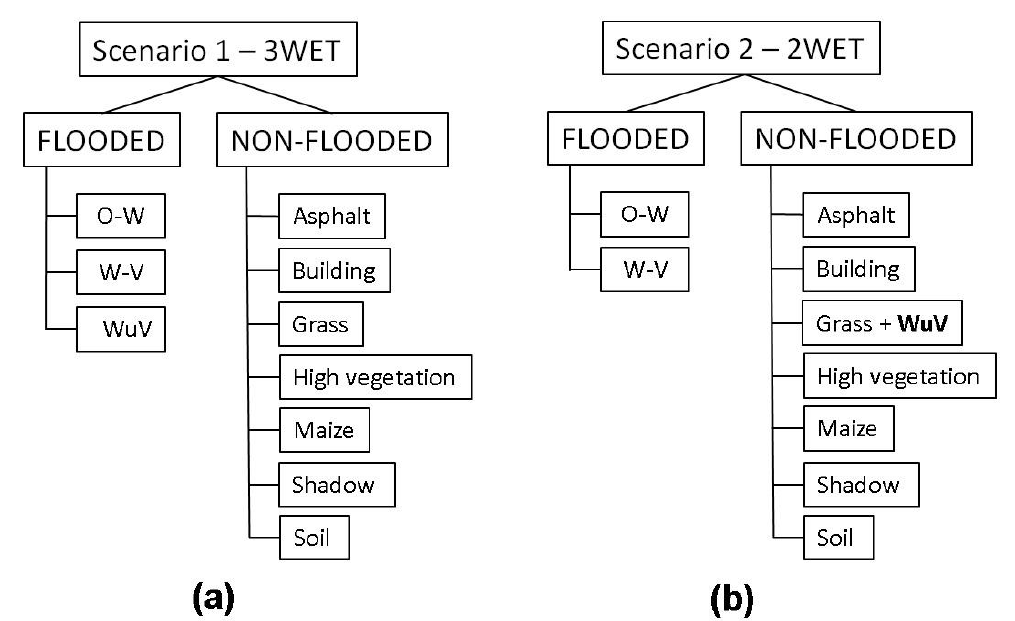
Figure 6. The class sets and class hierarchies of the two analysis scenarios, 3WET ( a ) and 2WET ( b ) used in the study. The figure shows that in the 2WET scenario the flooded class WuV from 3WET scenario was merged with the non-flooded class